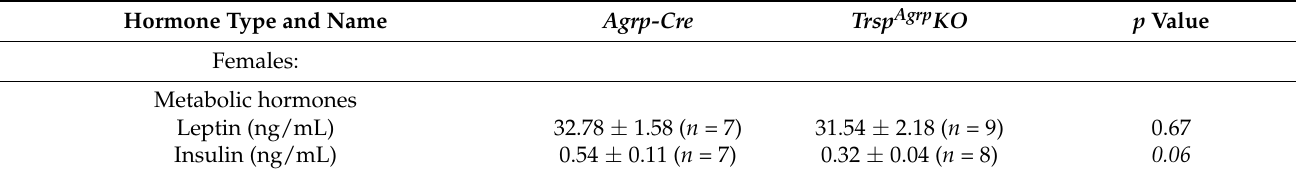
Table 1. Serum expression levels of hormones Trsp Agrp KO and Agrp-Cre mice.